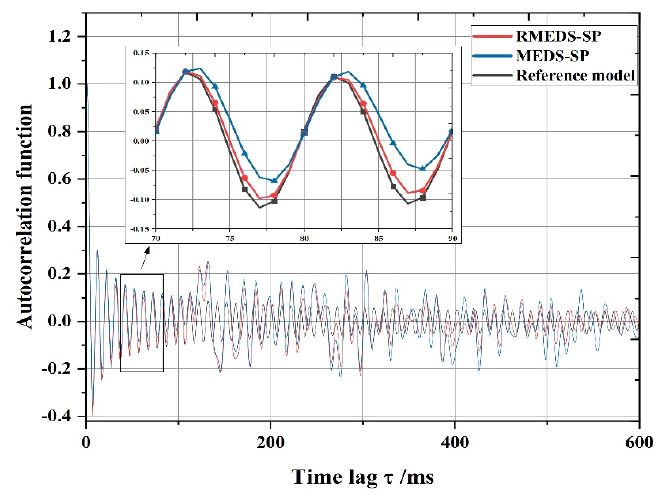
Figure 9. ACF of different models.